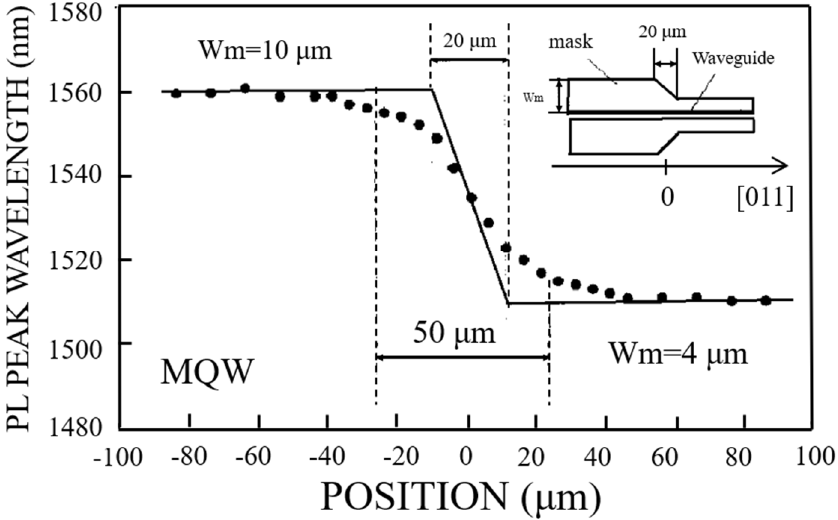
Figure 4. PL peak wavelength profile for MQW structure along [011] direction. A 20 µ m tapered transition region formed between the 10 µ m and 4 µ m wide mask. The inset is mask configuration. Reprinted with permission from ref. [31] © Elsevier. Copyright 1993 Journal of Crystal Growth.